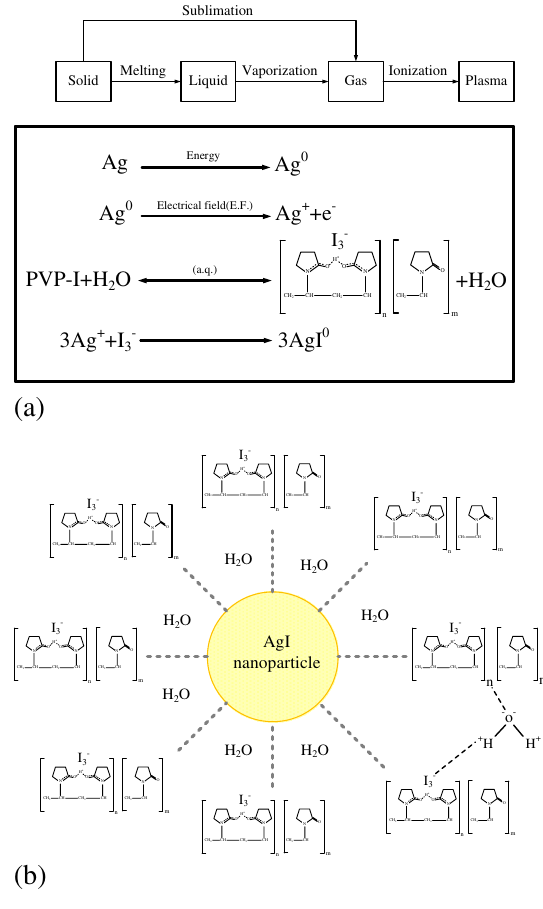
Figure 3. ( a ) Ionization of AgI; ( b ) suspension of